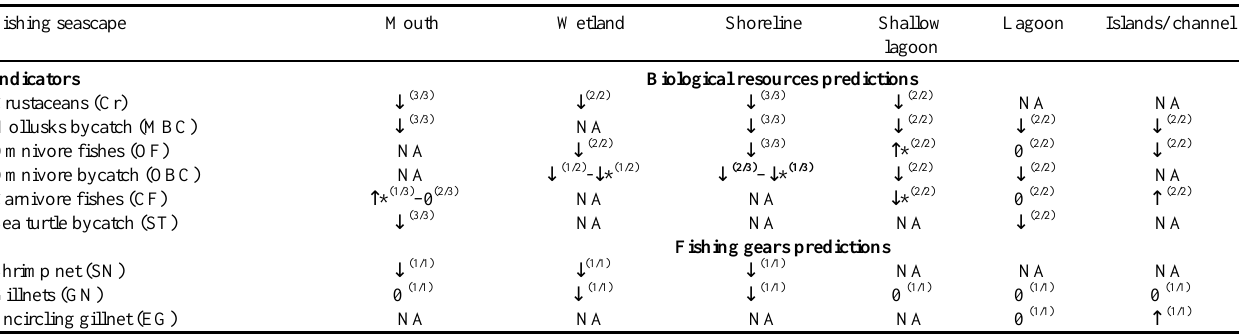
Table 4 . Model predictions that show the response of the entire community when the management strategy oriented to reduce carnivore bycatch (CBC) is reinforced. Parentheses indicate the proportion of models from the same seascape that suggest the specified response. Example (in bold): Omnivore Bycatch fl (2/3) - fl * (1/3) = Two out of three positive predictions were significant and one out of three were not significant (*). NA = Scenarios where this indicator is not present in the system. › = Positive prediction (suggesting an increase in the group abundance); fl = Negative prediction (suggesting a decrease in the group abundance); 0 = No